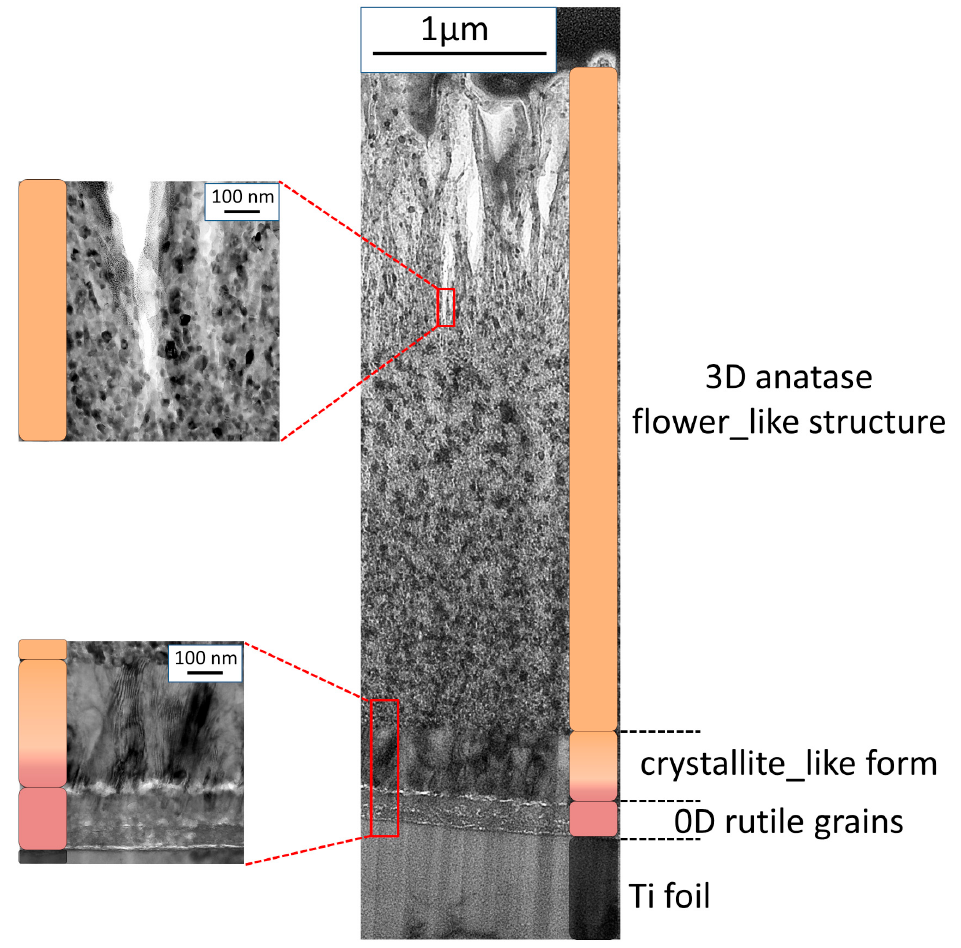
Figure 6. Cross section of the obtained flower-like nanostructure after 240 min titanium foil chemical oxidation and annealing at 600°C in Ar.